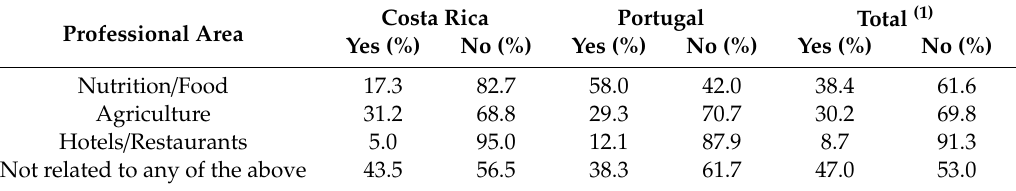
Table 2. Professional area of the